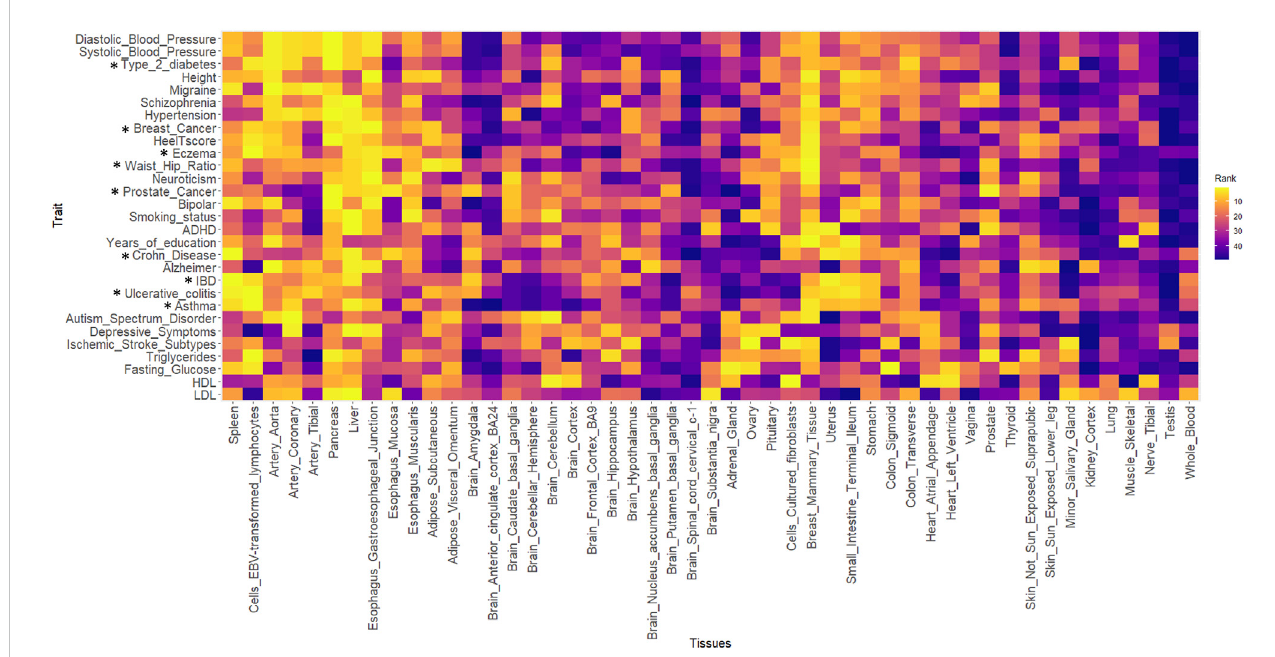
FIGURE 4 Theheatmapforallthetraitsagainst49GTExtissues.Theyellowcolourindicatesthetissuesthatareenrichedwithregulatoryeffectsforaparticulartrait. * represents the traits present in the training